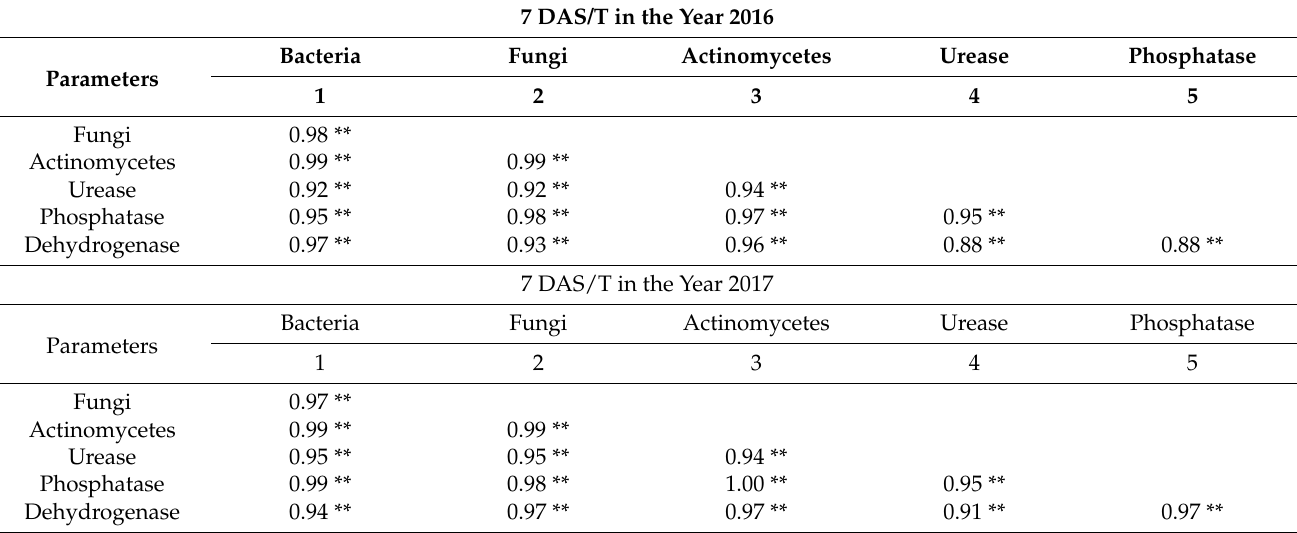
Table 11. Multiple correlations between micro-organisms and soil enzymes at different stages were recorded at 7 and 14 DAS in both years. 7 DAS/T in the Year